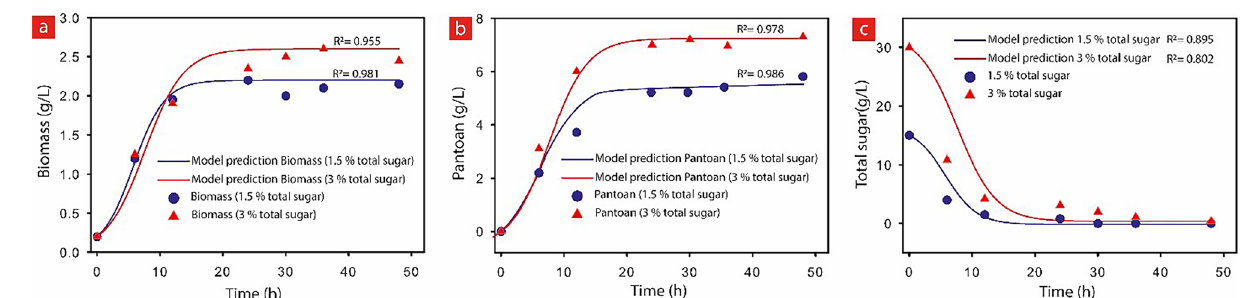
Figure 2. Kinetic studies using GraphPad Prism 9 (GraphPad Software, San Diego, CA).. Experimental (symbols) and modeling results (continuous lines) showing kinetics through time for ( a ) The Biomass, ( b ) Pantoan, and ( c ) total sugar, in the presence of 1.5 and 3%